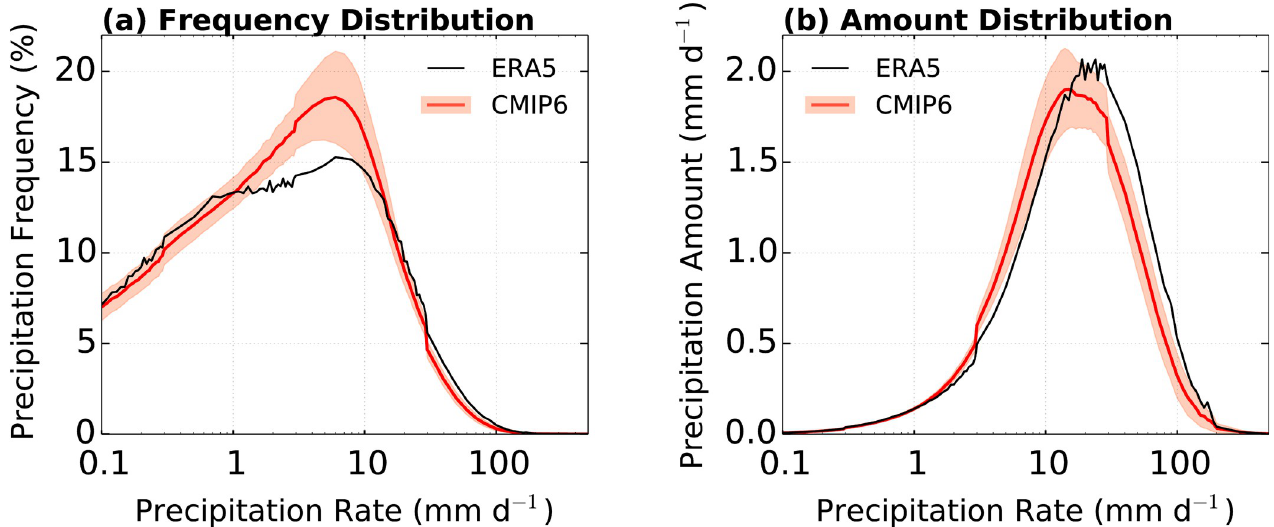
Fig 4. Daily precipitation over the EA domain for distributions of (a) precipitation frequency (%) and (b) precipitation amount (mm d − 1 ) in ERA5 and CMIP6 ensembles. The red shading is 95% confidence in the CMIP6 ensemble. Black and red lines indicate ERA5 and CMIP6 ensemble, respectively.